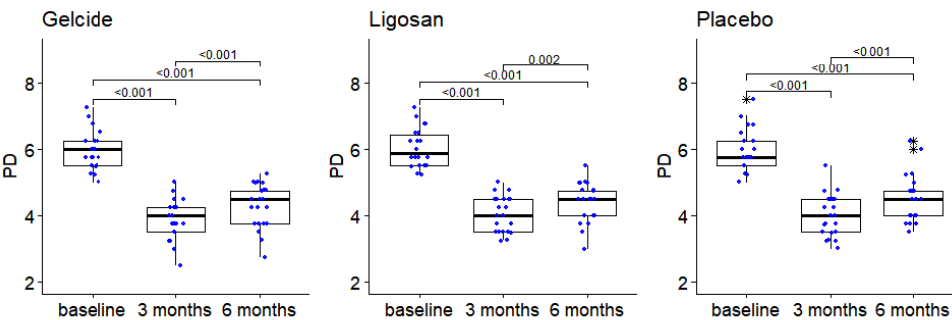
Figure 3. The evolution of the PPD between successive time points in the three groups (numbers in brackets represent p -values of Wilcoxon tests for pairwise intragroup comparisons). Boxplot depicts median and interquartile range, large stars represent outliers; data points displayed as superimposed dot plots.